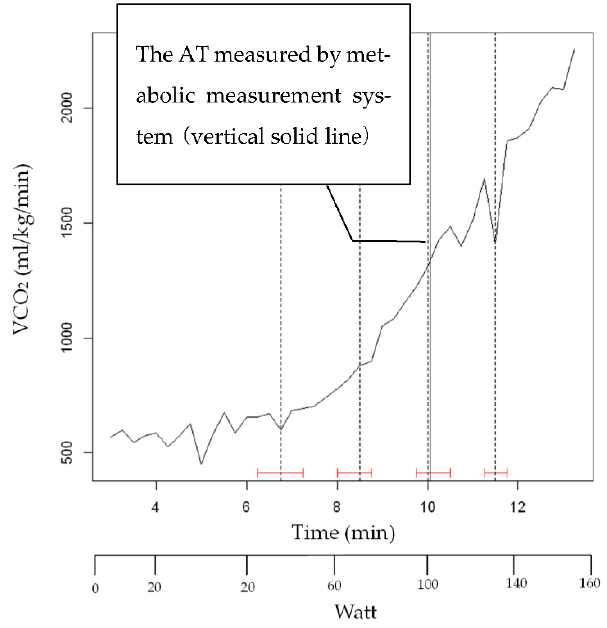
Figure 9. The results of strucchange results of VCO 2 (subject K) after smoothing. The number of breakpoints (RQ). The results of strucchange in the VCO 2 of subject K are shown in Figure 10. Because the number of change points is analyzed through both BIC and RSS analyses, there are three change points detected by strucchange.